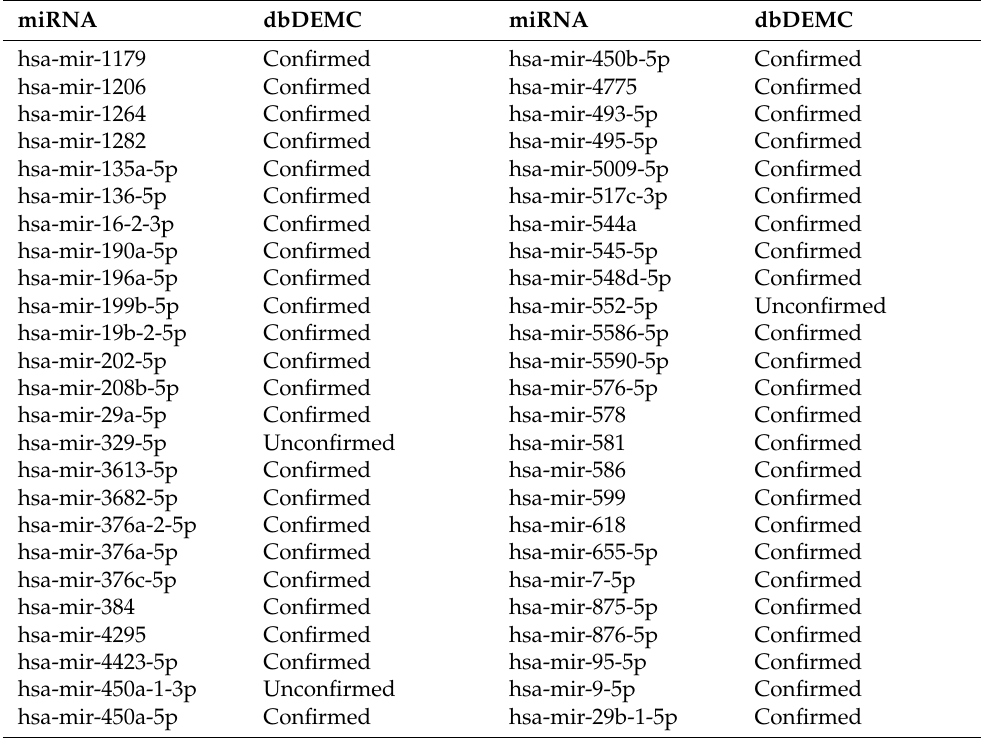
Table 3. Esophageal neoplasm associated miRNA Top 50 predicted by hmdd v3.2.